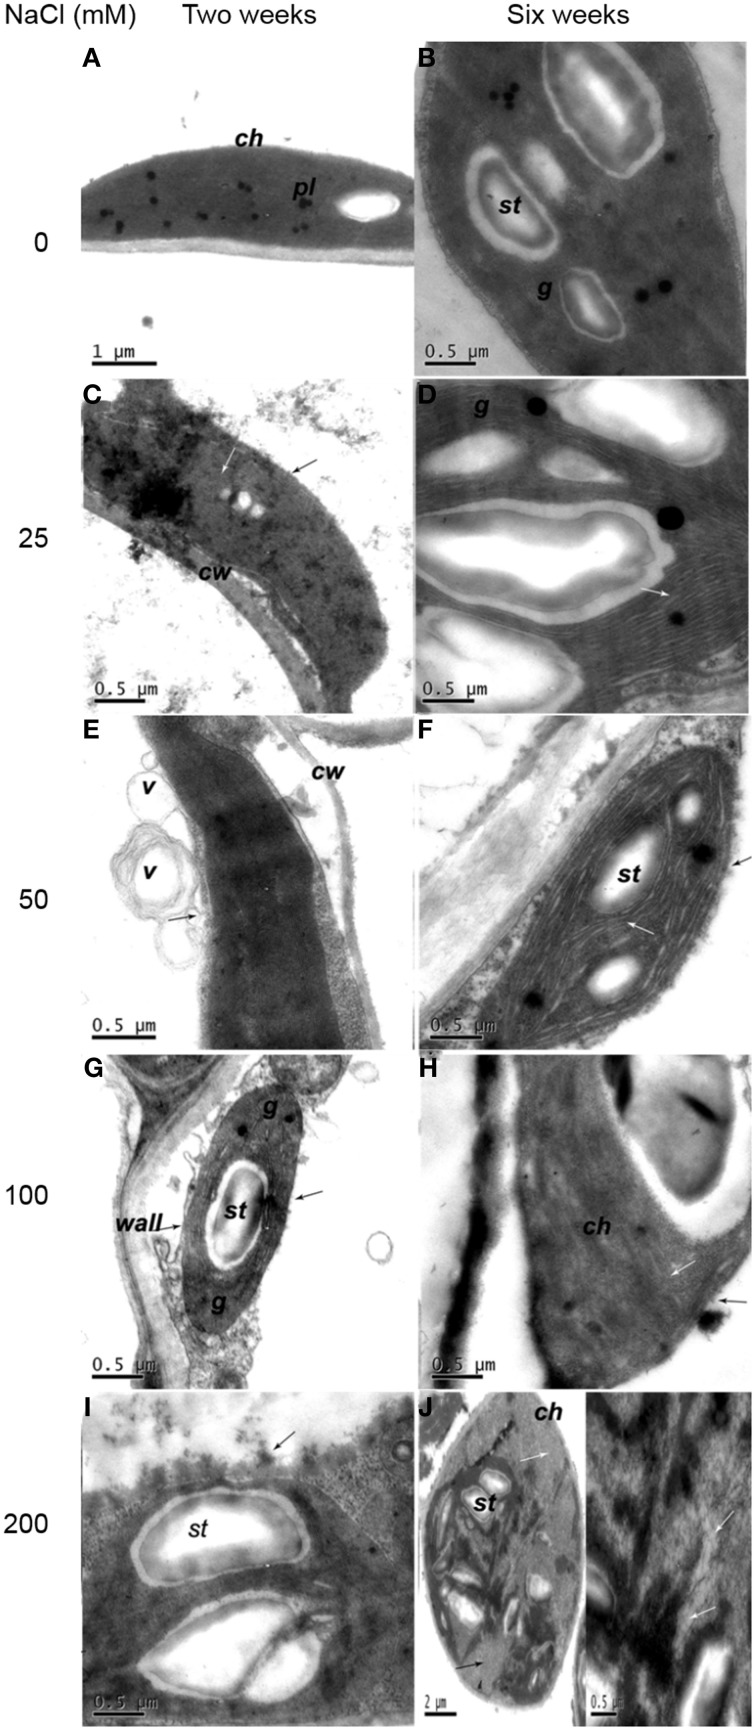
Ultrastructural changes of chloroplast in mesophyll cell. (A) Two weeks of non-salinity: ellipse- or spindle-shaped chloroplast with few and small starch. (B) Six weeks of non-salinity: chloroplast structure was complete. (C) Two weeks of 25 mM NaCl: chloroplast with vague outer membranes (black arrows) showed distended thylakoids (white arrows). (D) Six weeks of 25 mM NaCl: obvious swelling of the thylakoid (white arrow). (E) Two weeks of 50 mM NaCl: chloroplast envelope evagination, forming vesicles (black arrow). (F) Two weeks of 50 mM NaCl: chloroplast envelope disruption (black arrow) and distorted lamella (white arrow). (G) Two weeks of 100 mM NaCl: chloroplast envelope disintegration (black arrow) and thicker cell walls and partially dissolved grana thylakoid. (H) Six weeks of 100 mM NaCl: envelope (black arrow) and lamellar structure (white arrow) partly dissolved. (I) Two weeks of 200 mM NaCl: chloroplast disintegrated with inclusions effused (black arrows). (J) Six weeks of 200 mM NaCl: the grana and stromal lamella of chloroplast digest basically (black arrow), while thylakoids disintegrate and cavitate gradually (white arrows). Note: ch, chloroplast; g, grana; pl, plastoglobuli; st, starch grains; w, cell wall; is, intercellular space; v, vesicle.